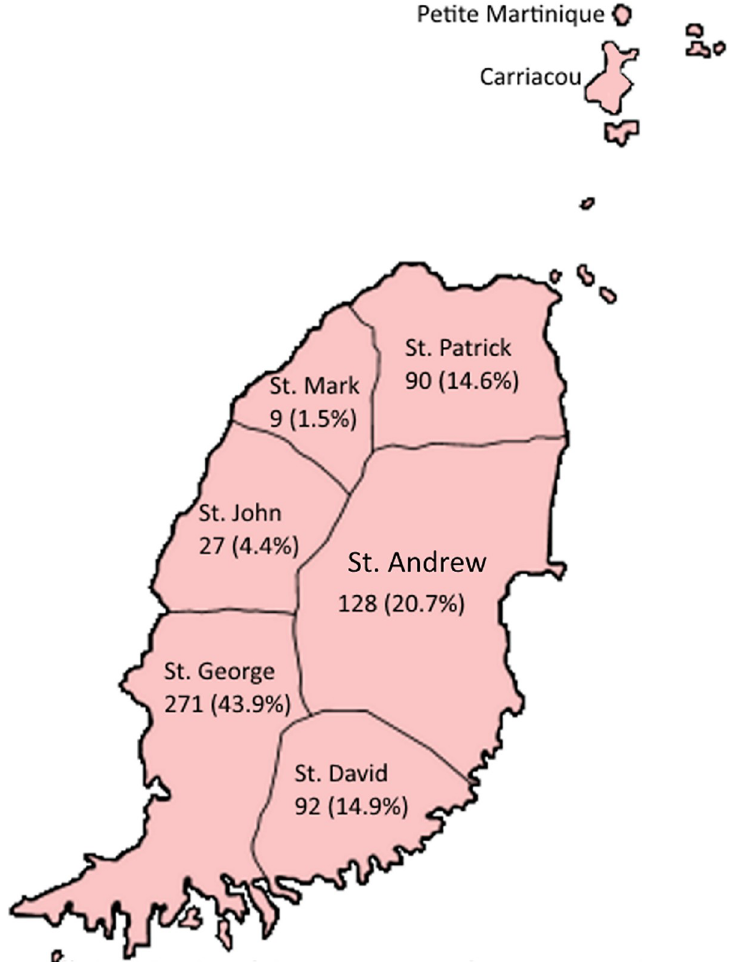
Fig 1. Distribution of respondents across the